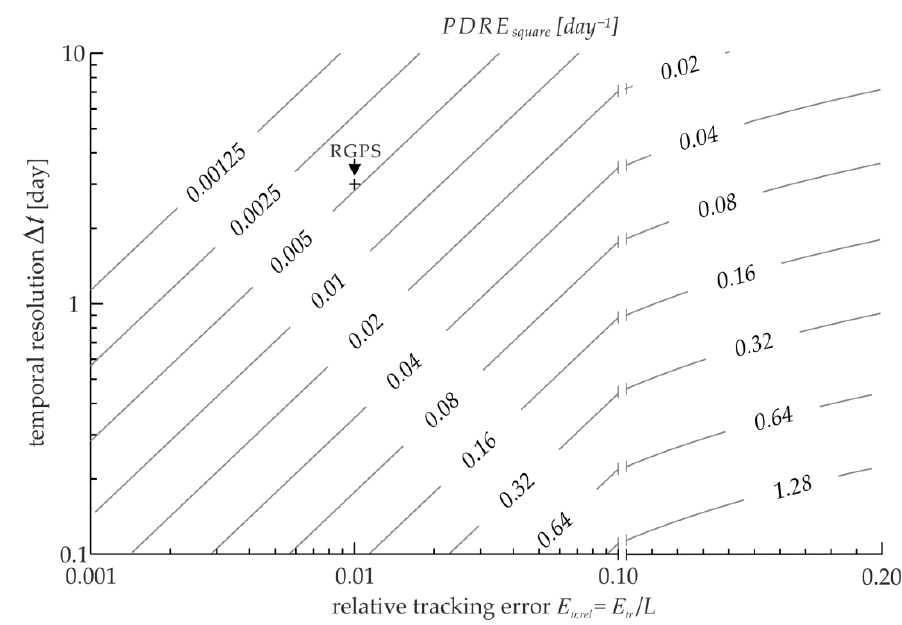
Figure 4. Propagated drift retrieval error (PDRE) per day (in a grid consisting of squares with sides of length L ) for typical time gaps between synthetic aperture radar (SAR) image pairs used for deriving sea ice drift, given a realistic range of tracking errors. The PDRE of deformation parameters derived from RGPS (RADARSAT Geophysical Processor System) data reported in Lindsay and Stern [16] is marked by a cross.